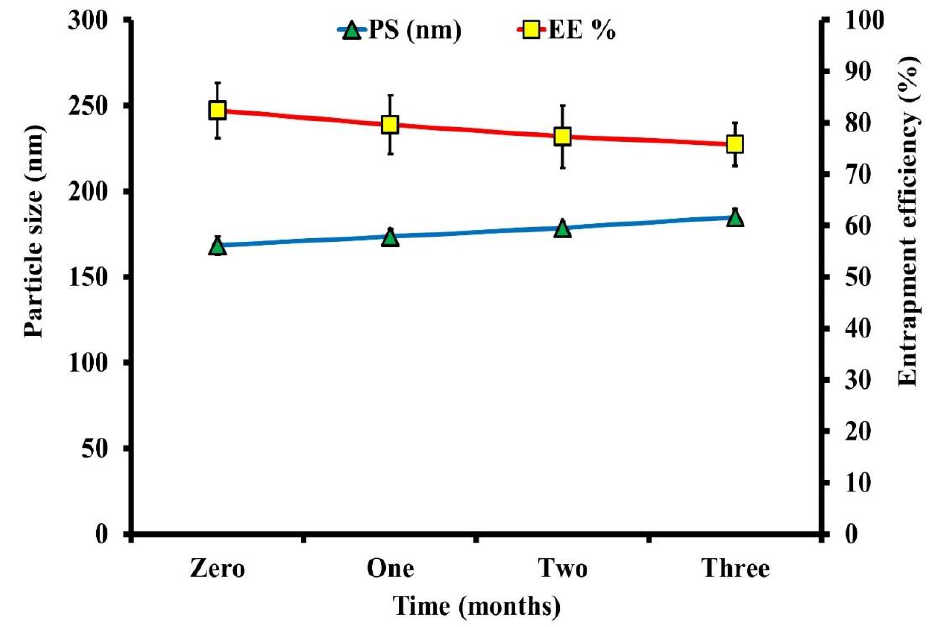
Figure 5. The effect of 3 months of storage at 4 °C on the PS and EE% of the optimized BER-LC-CTS- NPs formulation.